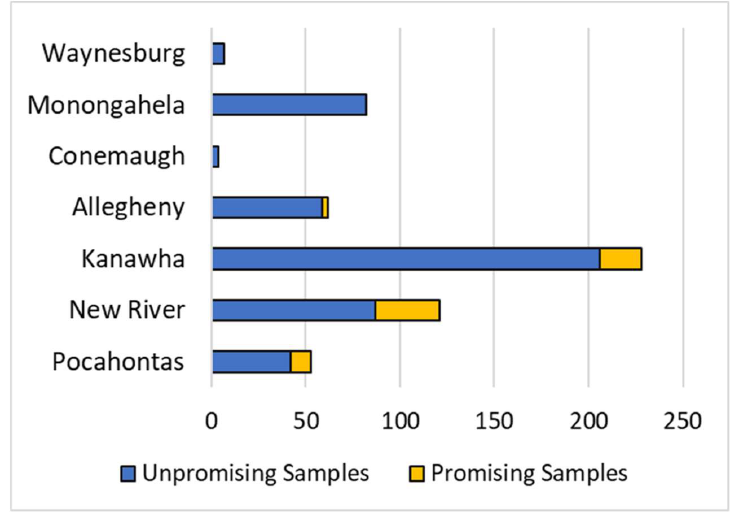
Figure 11. Total ash-basis promising and unpromising samples by geologic